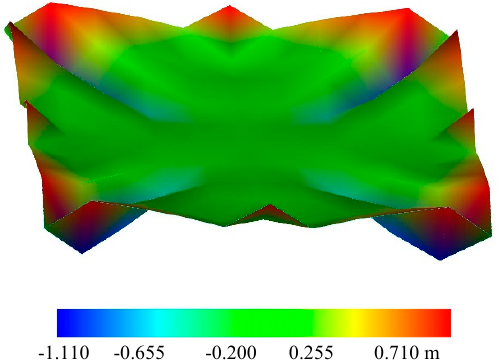
Figure 5. The distribution of the surface height differences of Scheme A and B at Step 248.